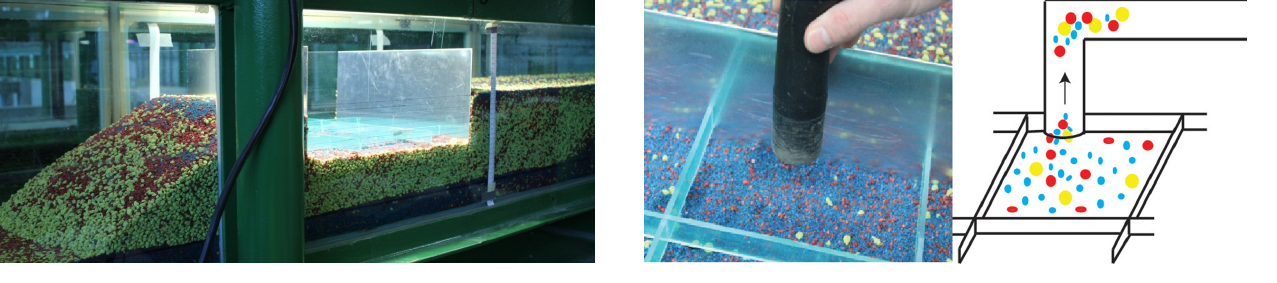
Figure 5. Nozzle of vacuum cleaner close to the bed surface re- moving the 1cm sediment